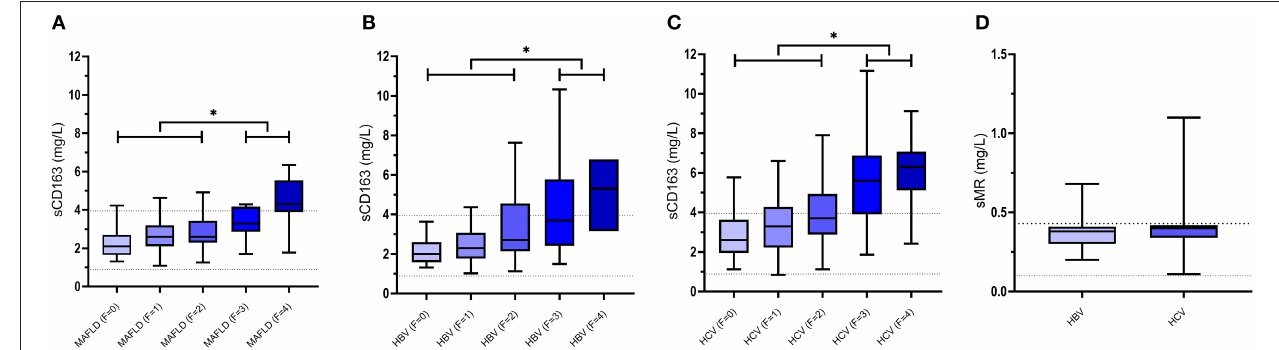
FIGURE 2 | Concentrations of sCD163 in MAFLD (A) , chronic HBV infections (B) and chronic HCV infections (C) as well as concentrations of sMR in chronic HBV infections and chronic HCV infections (D) presented by means/medians, interquartile ranges as well as minimum and maximum values. In patients with MAFLD, chronic HBV infections and chronic HCV infections plasma levels of sCD163 increase with increasing fibrosis grade (F0-F4) (40, 44, 51, 67) with significantly higher levels in patients with fibrosis grades F3-F4 compared with patients with fibrosis grades F0-F2 (* p -value < 0.001). Dotted lines represent upper and lower reference values for healthy controls (26, 34). MAFLD, metabolic associated fatty liver disease; HBV, hepatitis B virus; HCV, hepatitis C virus; sCD163, soluble cluster of differentiation 163; sMR, soluble mannose receptor.